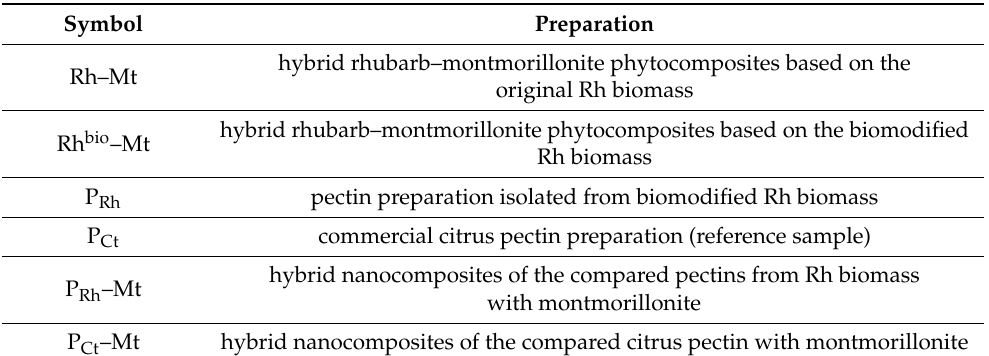
Table 1. Objects of research.